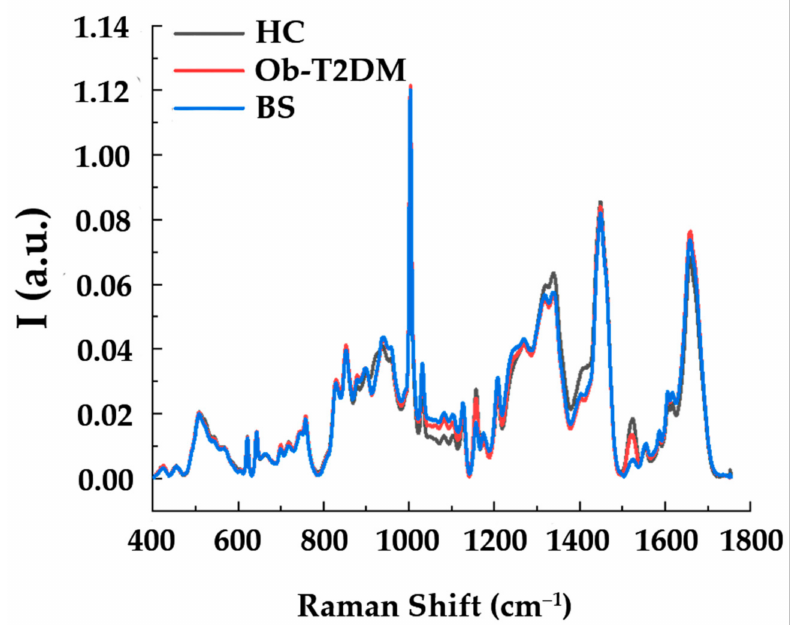
Figure 3. Average normalized Raman spectra of all serum samples. Grey spectra corresponded to the average of 23 spectra in the HC patients, while the red and blue signals represent the normalized average of 14 spectra collected from Ob-T2DM subjects before and after BS,